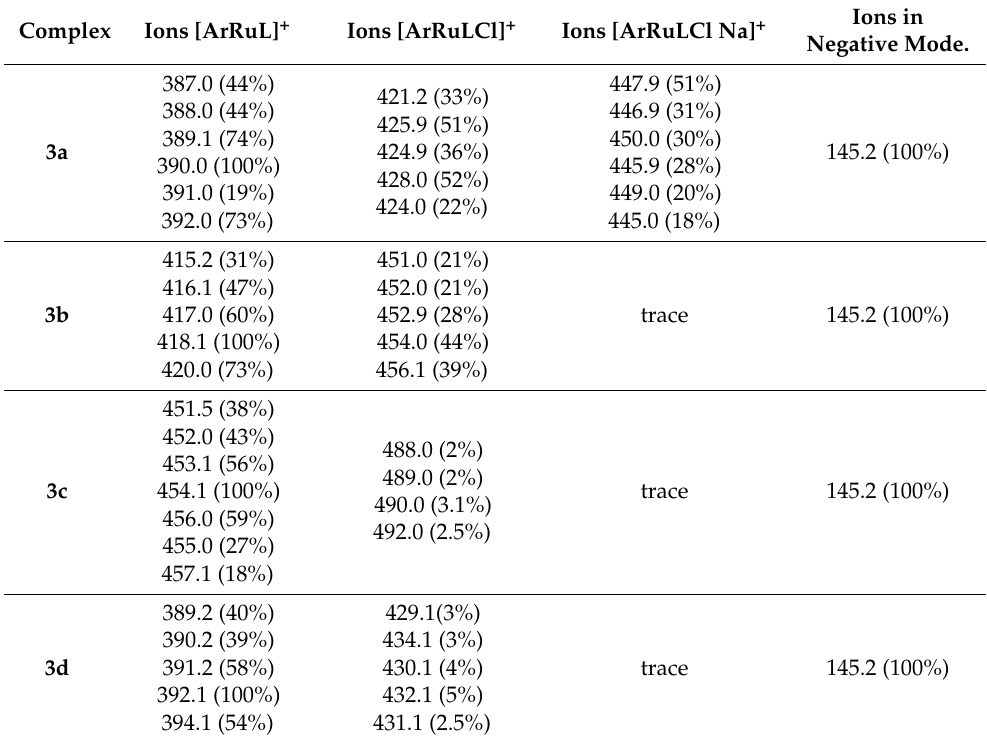
Table 1. ESI-MS data of [PF 6 ] − arene-ruthenium(II) salts complexes 3a – 3d . Complex Ions [ArRuL] + Ions [ArRuLCl] + Ions [ArRuLCl Na] +